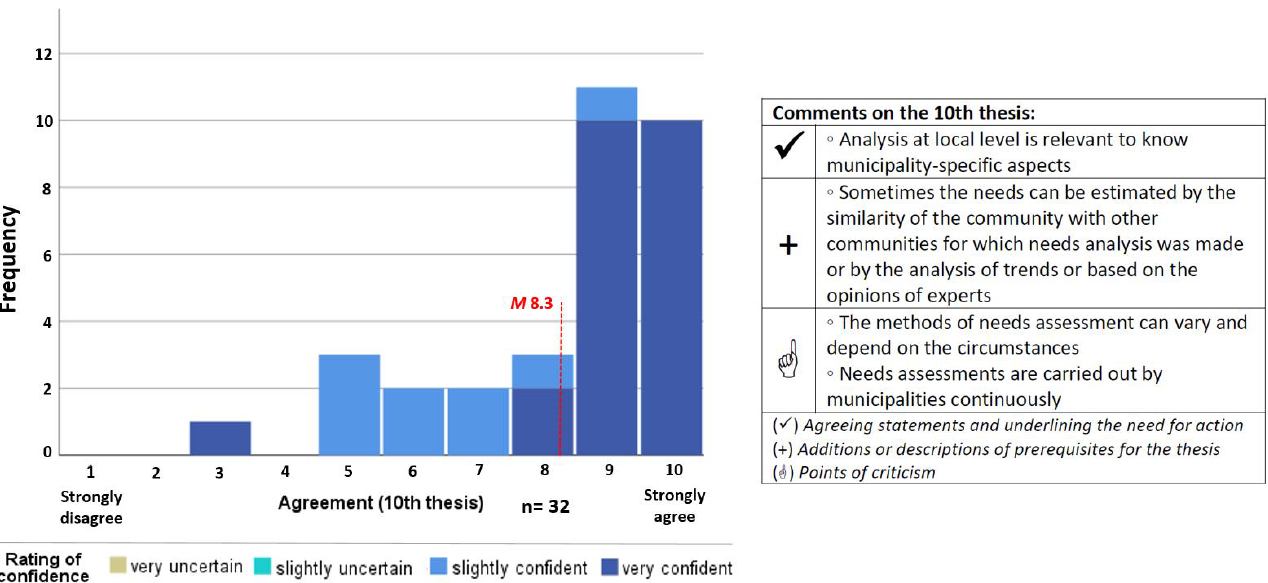
Figure 2. Example of how the results from the first round of interviews were presented in the second round of the Delphi survey.